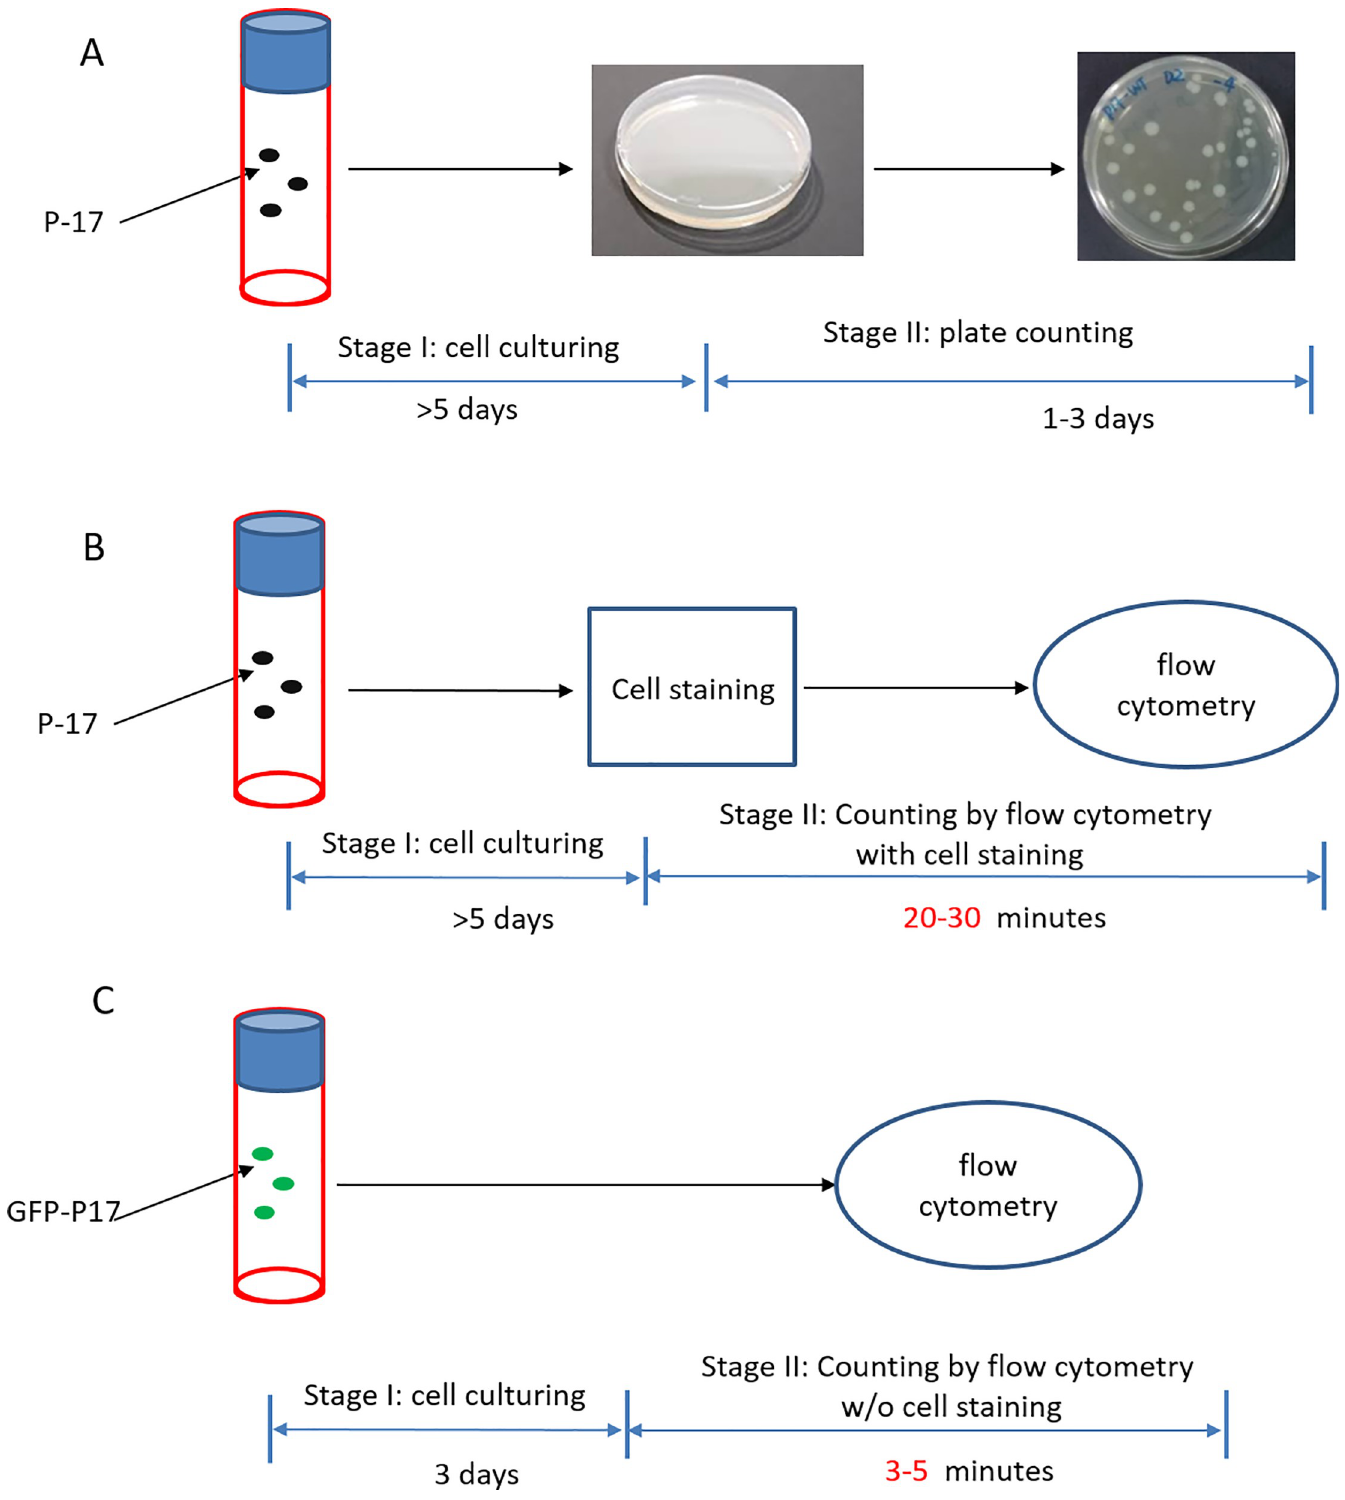
Fig 5. Schematic presentation of our method compared to other methods. ( A) Conventional method. (B) Flow cytometric method with cell staining. (C) Our flow cytometric method without cell staining.